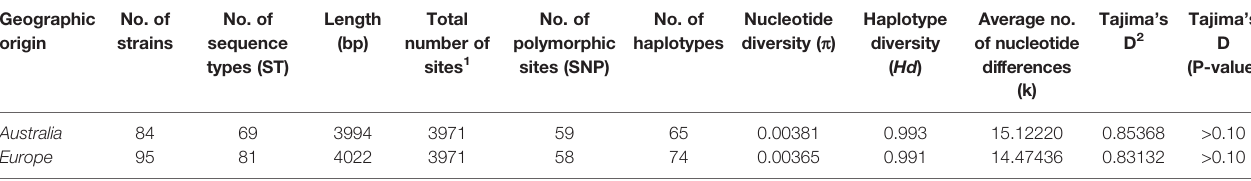
TABLE 4 | Comparison of neutrality and genetic variability of concatenated MLST sequences from Australia and Europe. Geographic